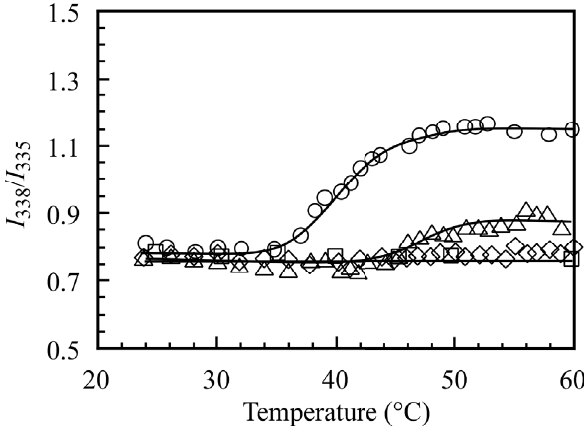
/ I in pyrene excitation spectra in the presence of PMPC Figure 9. I 338 335 PMPC -PDEA ( △ ), PMPC 64 46 a function of temperature in 0.1 M NaCl aqueous